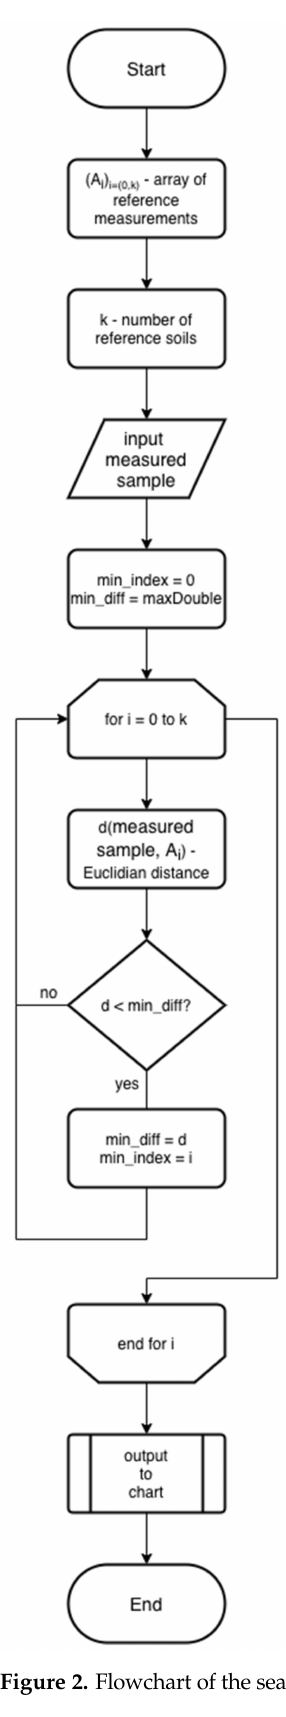
Figure 2. Flowchart of the search of the reference with a minimum deviation using Euclidean